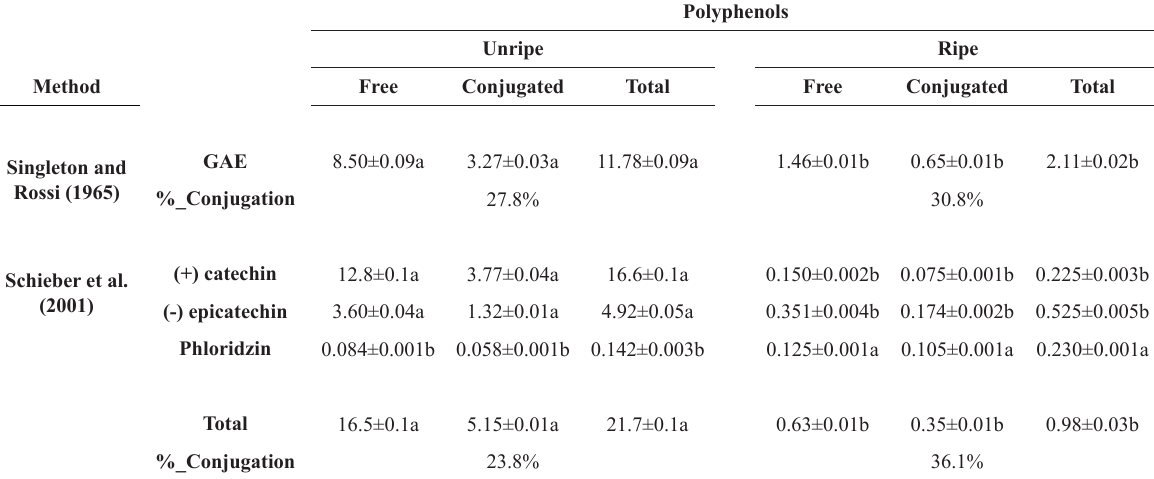
Total polyphenol and single polyphenol content of unripe and fully ripe ackee